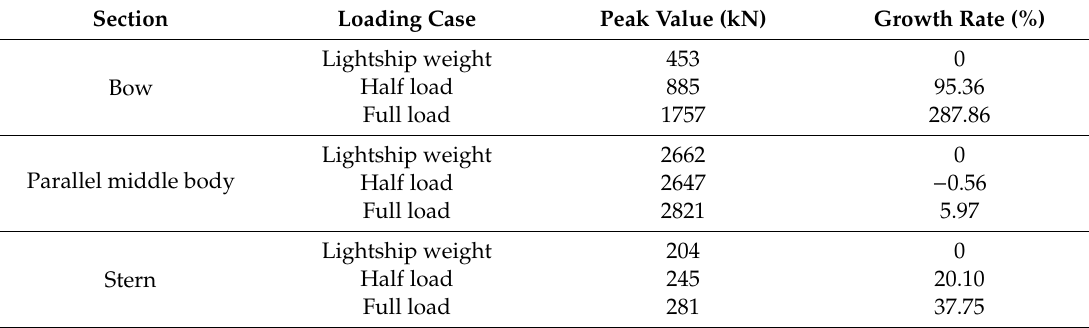
Figure 28. Pressure at P2 of each section at different loading conditions: ( a ) Lightship weight; ( b ) half load; ( c ) full load. Table 8. The peak value of the pressure at P2 of each section at different loading conditions.